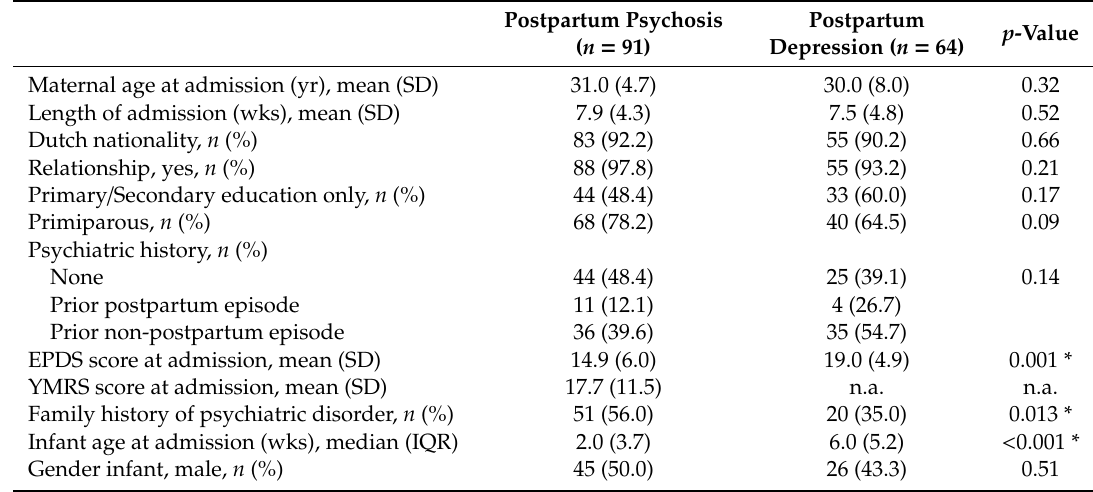
Table 1. Demographic and clinical characteristics.